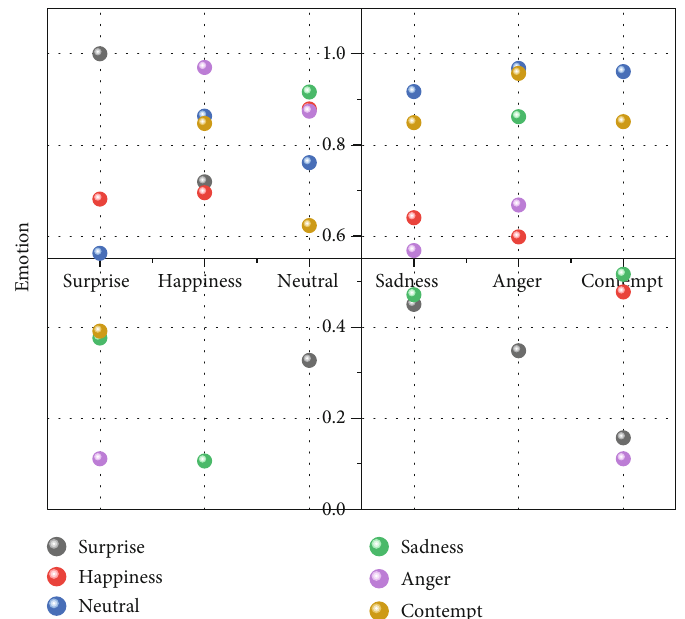
Figure 8: Emotional data correlation